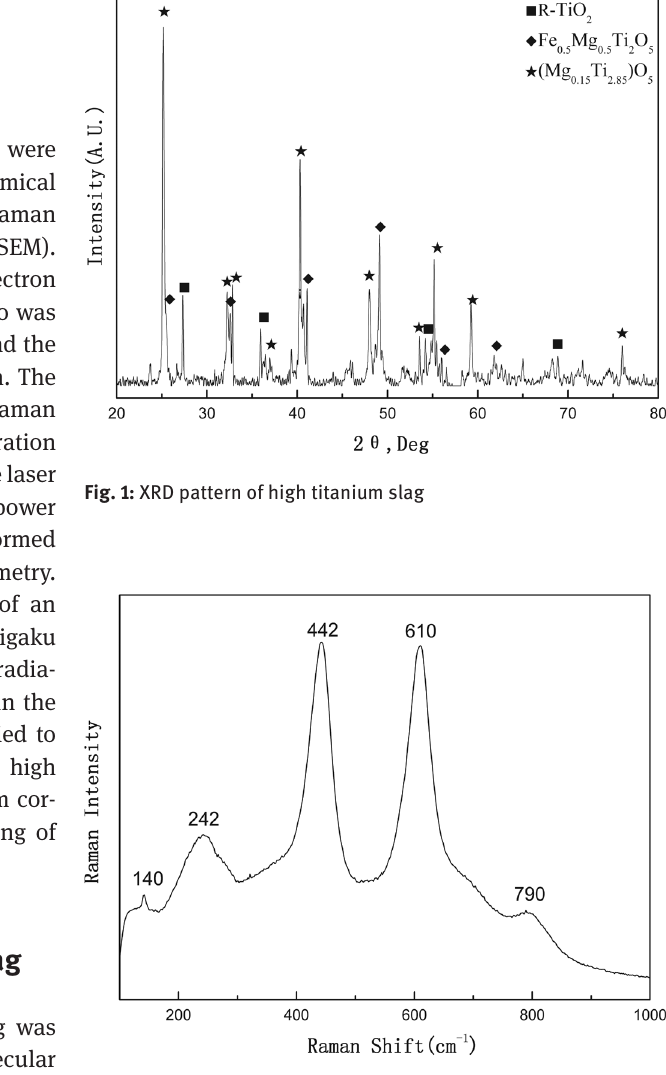
Fig. 2: Raman spectrum for high titanium